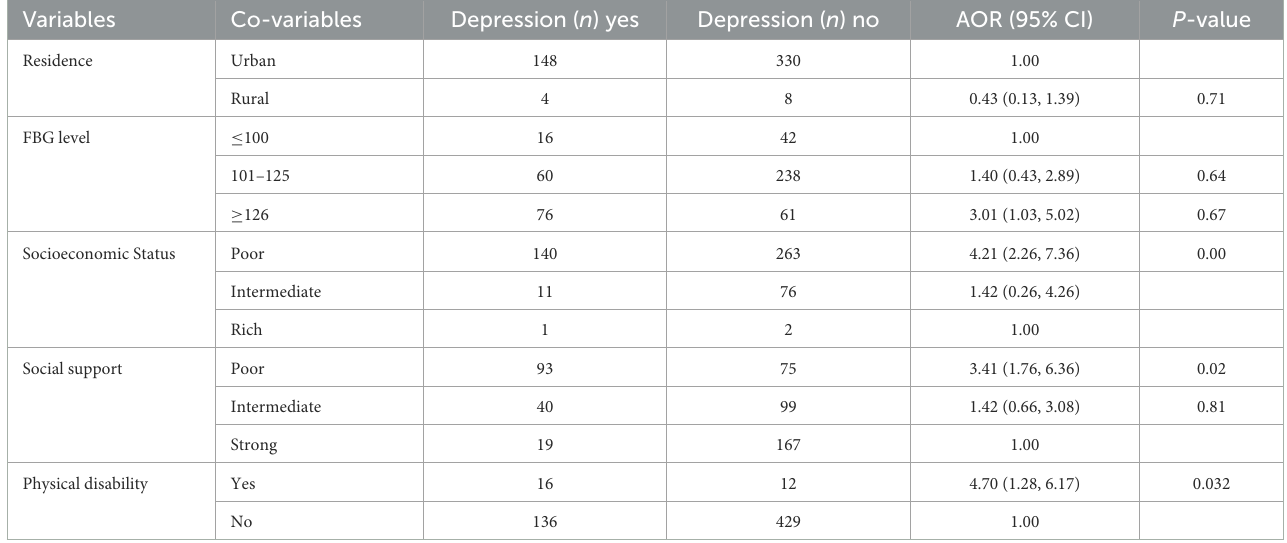
TABLE 4 Multivariate analysis of depression among patients with diabetes mellitus attending the outpatient department at SINA Clinics [August–September 2022] ( N = 493, n = 152).